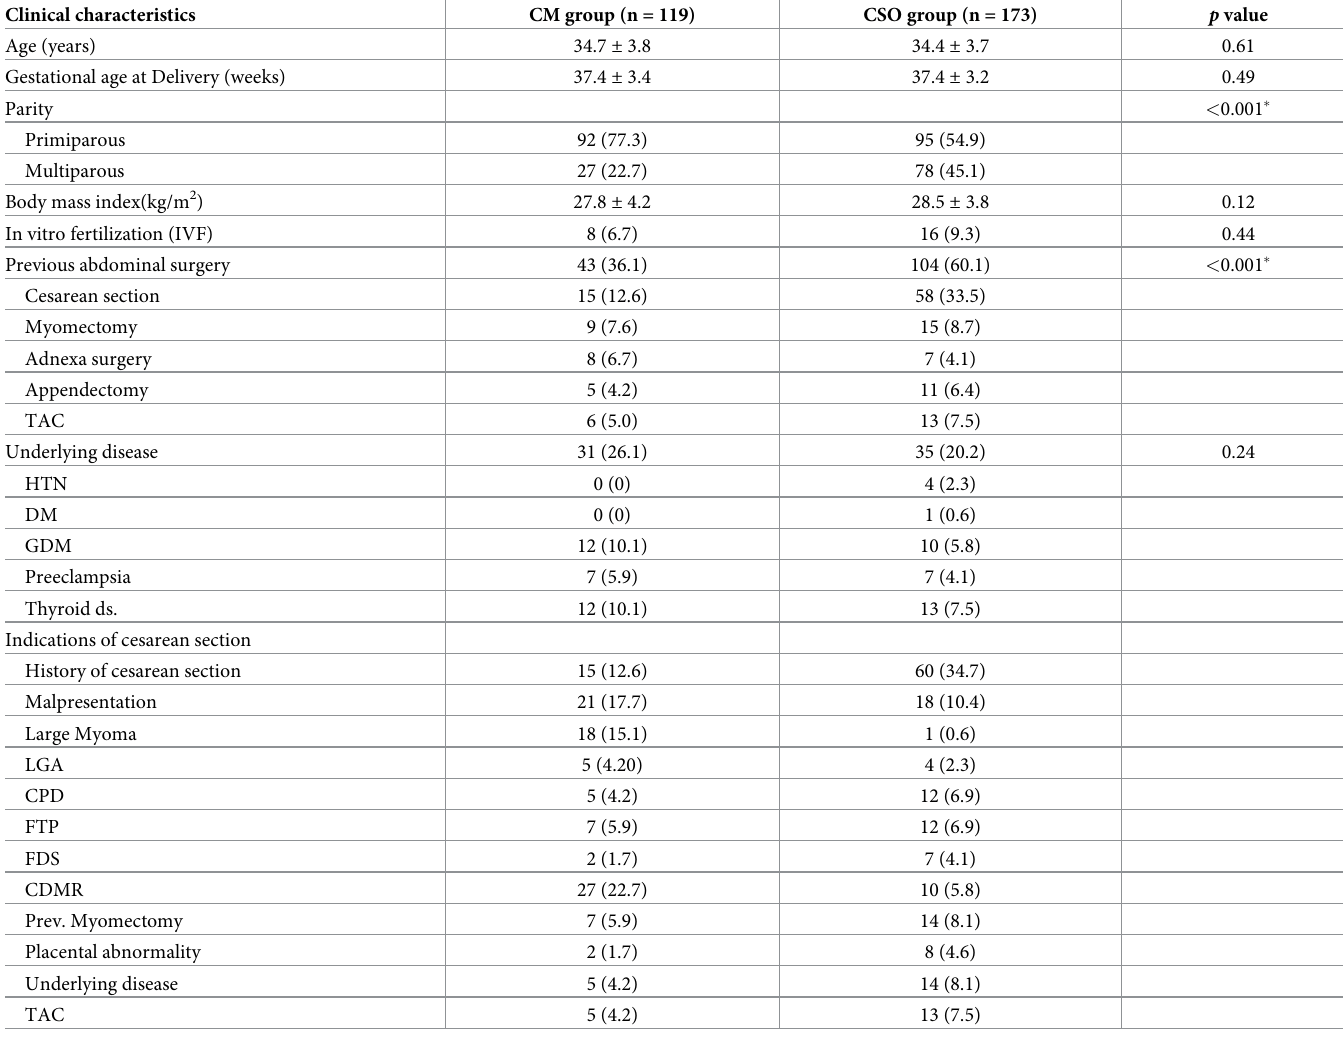
Table 1. Clinical characteristics of pregnant women with myomas taken cesarean sections (n =